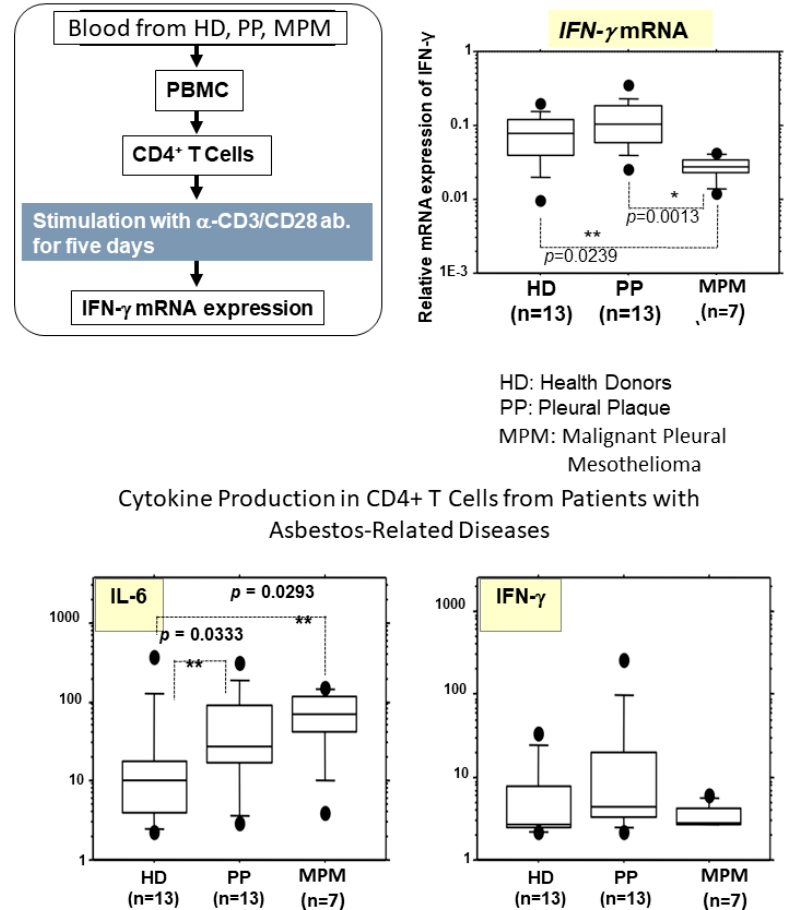
Figure 3. To investigate T cell functions altered by asbestos exposure, freshly isolated peripheral CD4+ T cells from healthy donors (HD), patients with pleural plaque (PP) or malignant mesothelioma (MPM) were stimulated with anti-CD3/28 antibodies for five days and IFN- γ mRNA expression was monitored. As a result, it was found that IFN- γ expression in CD4+ T cells from MPM patients was lower compared with that in cells derived from HD and PP. Regarding cytokines produced during stimulation of CD4+ T cells derived from HD, PP and MPM, IL-6 levels were higher in culture supernatants from PP and MPM compared with that from HD, although IFN- γ levels did not differ in supernatants from HD, PP and MPM. The p -value was obtained using the Mann-Whitney U test. * p < 0.01, ** p < 0.01. PBMC: peripheral blood mononuclear